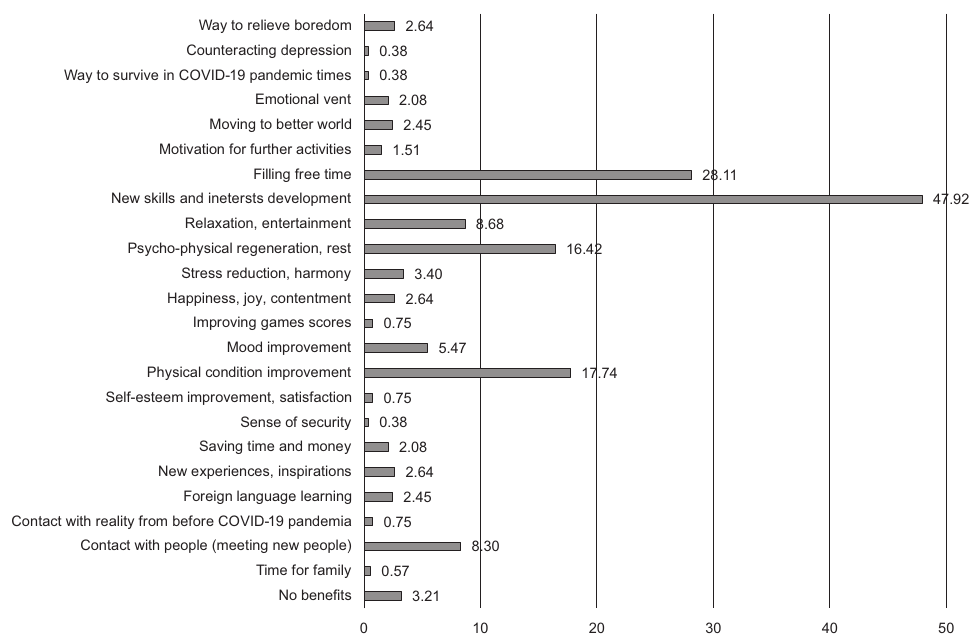
Fig. 4. benefits of participating in computer-based entertainment according to the respondents. Source: own elaboration based on online questionnaires.